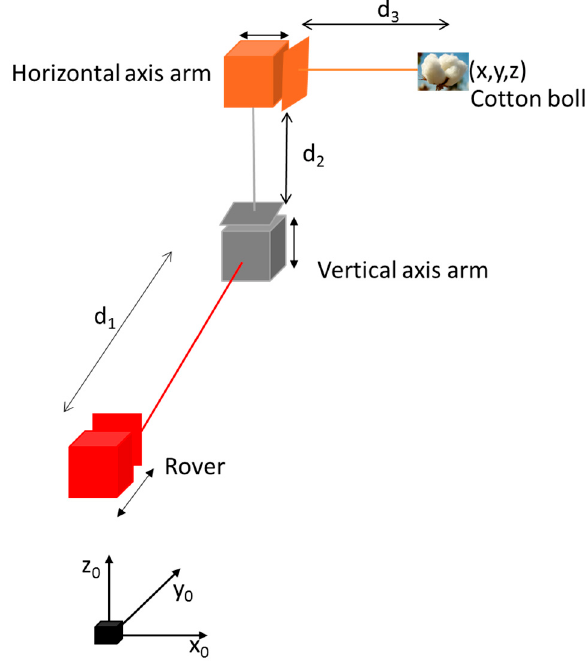
Figure 11. The inverse kinematics of the cotton-harvesting robot.